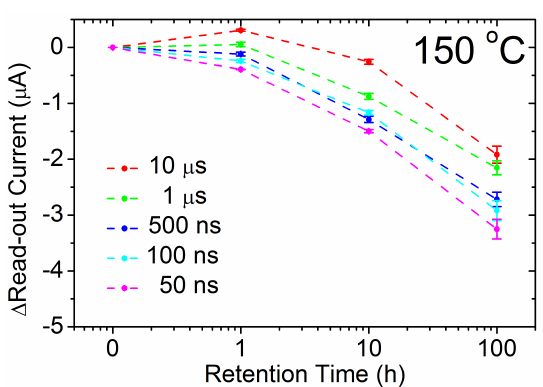
Figure 8. Variation of the mean and dispersion values of read-out currents sampled during the retention test compared to the ones obtained at the beginning of the annealing at 150 o C for every programming pulse width.